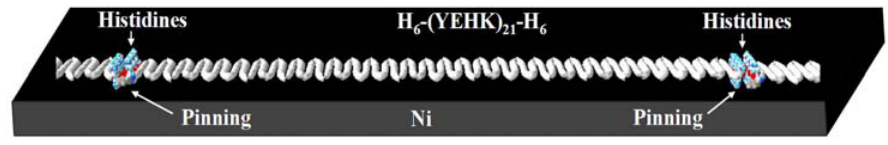
Figure 9. Pinning interactions of terminal hexahistidines with nickel substrate presumably leading to greater stability of H6-(YEHK)x21-H6 polypeptide fibrils on